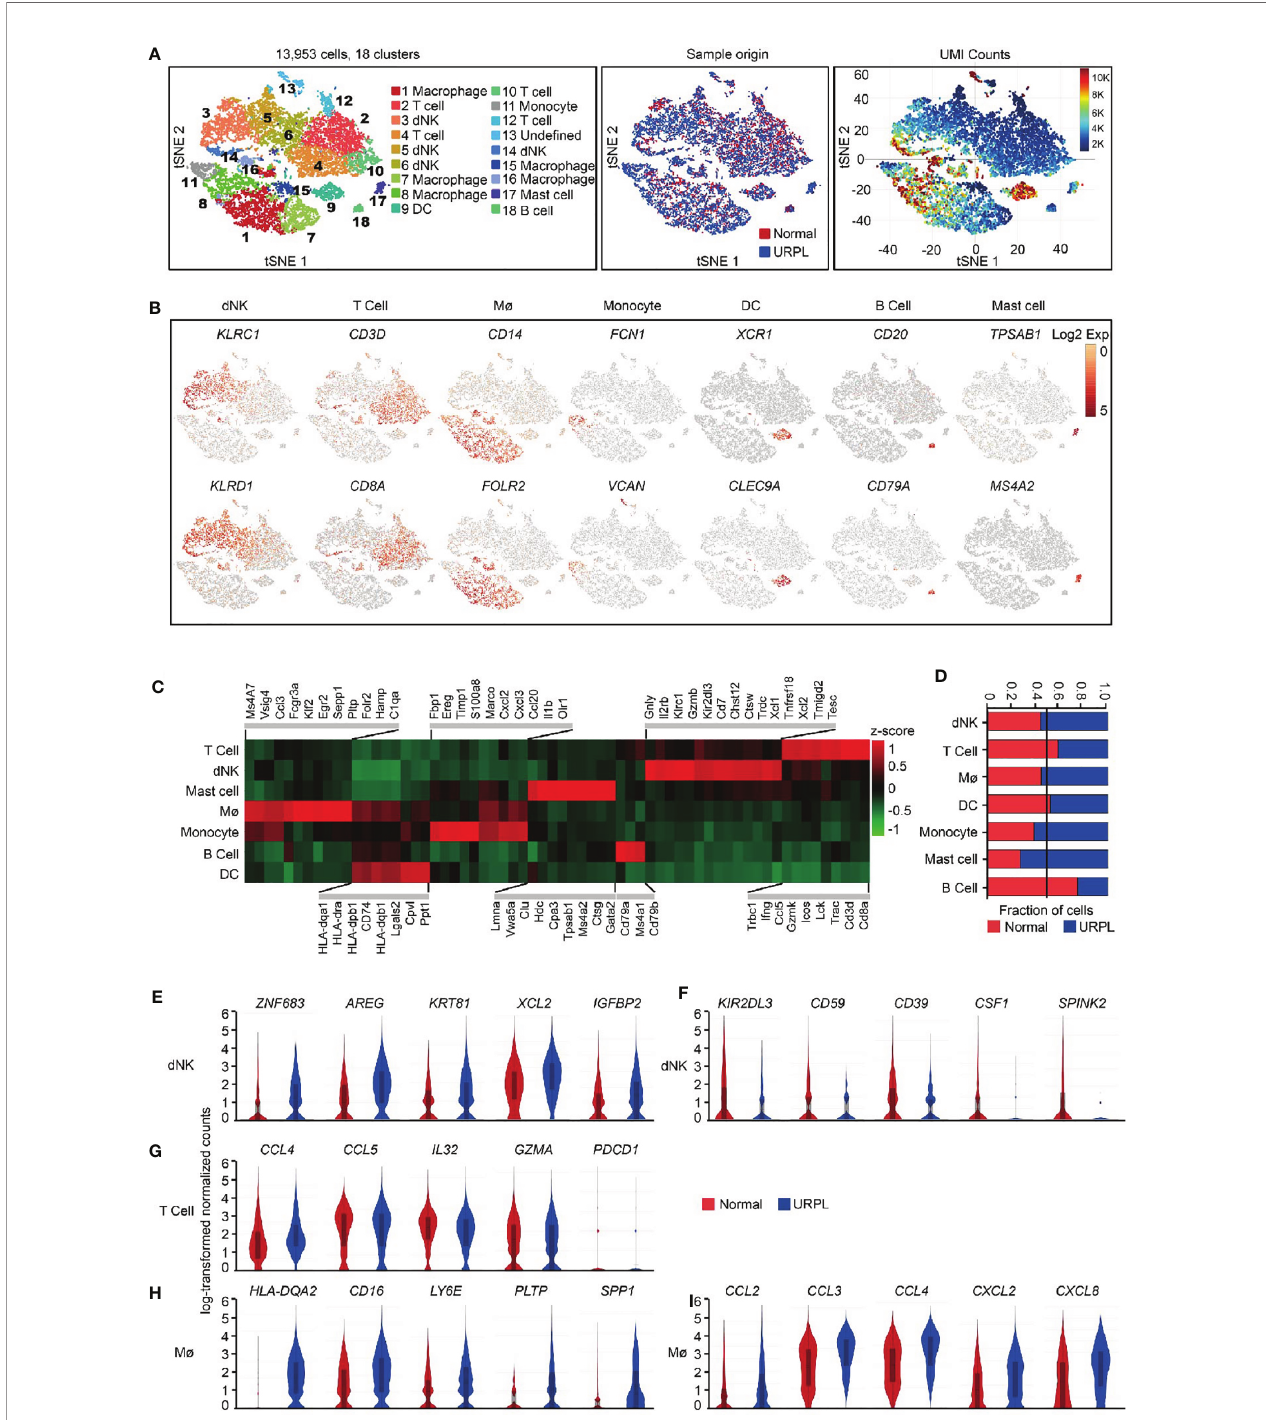
FIGURE 1 | Overview of the 13,953 CD45 + cells from URPL and normal deciduas. (A) tSNE of the total cells pro fi led here, with each cell colorcoded for. (B) tSNE visualization showed the expression of marker genes for the cell types above. (C) Heatmap of enriched genes expression within de fi ned populations. Expression is measured in units of log2. Heatmap of total signi fi cant expressed genes for each cell type was shown in supplementary Figure S1C . (D) The fraction of cells originating from URPL and normal control samples for the 6 de fi ned populations. (E – I) Violin plots showing the smoothened expression distribution of selected genes in (E, F) dNK cell, (G) T cell, (H, I) Mø strati fi ed by normal or URPL origins. Red and blue bar for normal (n=3) and URPL (n=3), respectively. Mø, macrophage. Analysis of gene expression in scRNA-seq data was performed in R (version 3.5.2) using